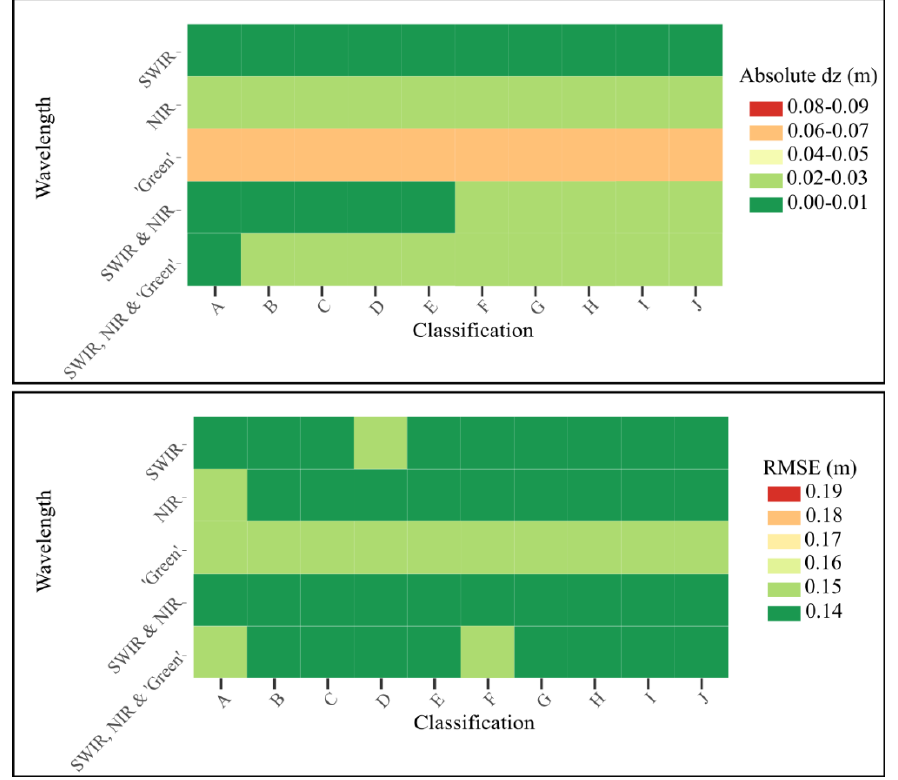
Figure 9. Ground classification results (| dz | and RMSE) in burned peatlands unsegregated based on vegetation regeneration two years post-fire (true representation of two years post-fire). Classifications were conducted in LASTools.